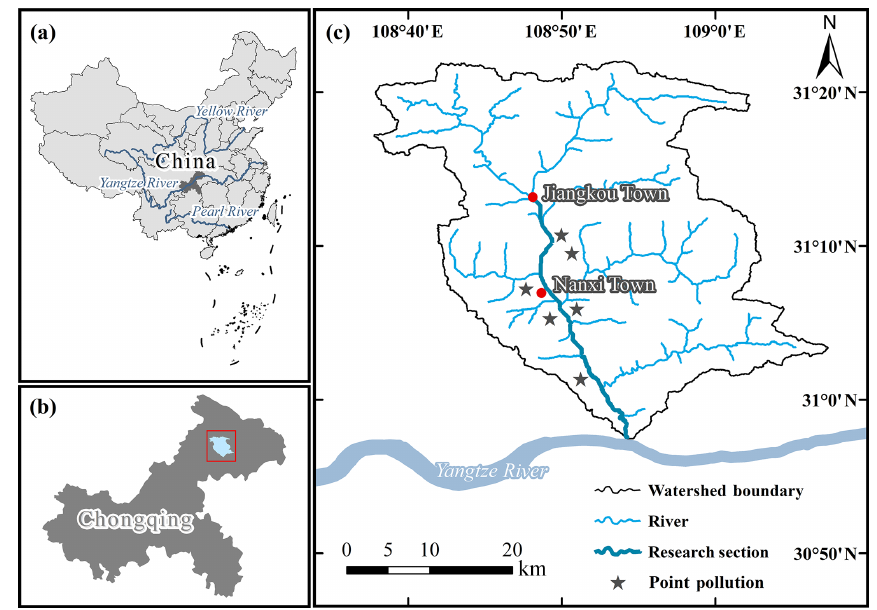
Figure 1. Research area and hydrologic system of the Tangxi River basin. (a) Location of the research area relative to the country scale. (b) Location of the research area relative to the city scale. (c) Hydrologic system of the research area.